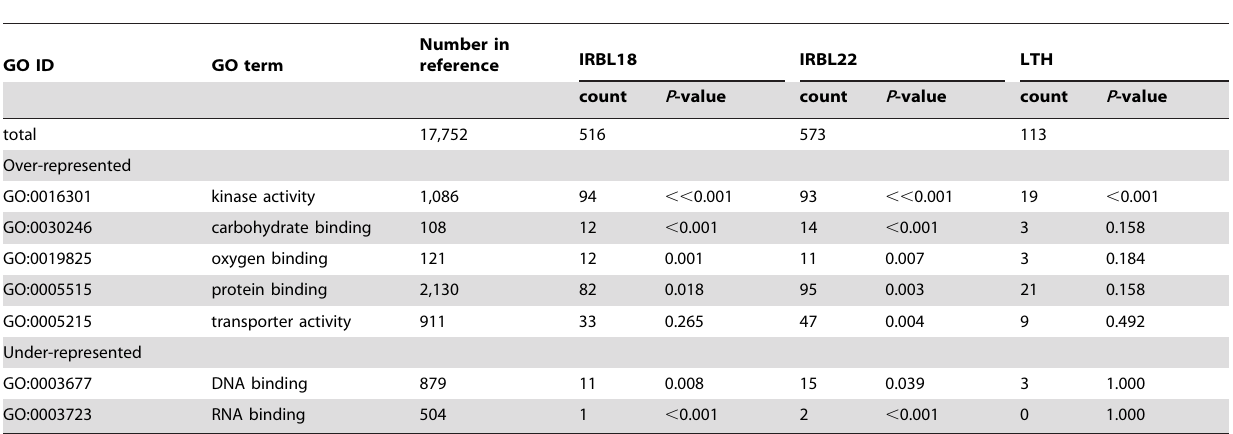
Table 1. The enrichment analysis of GO in the up-regulated